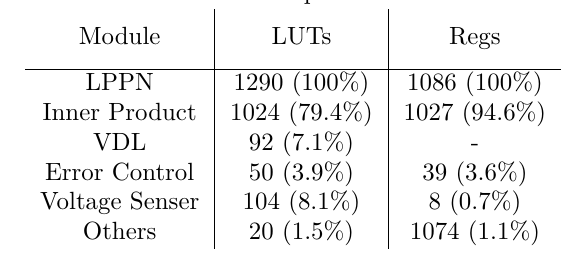
Table 1: Resource utilization of the LPPN processor on the Xilinx Spartan-6